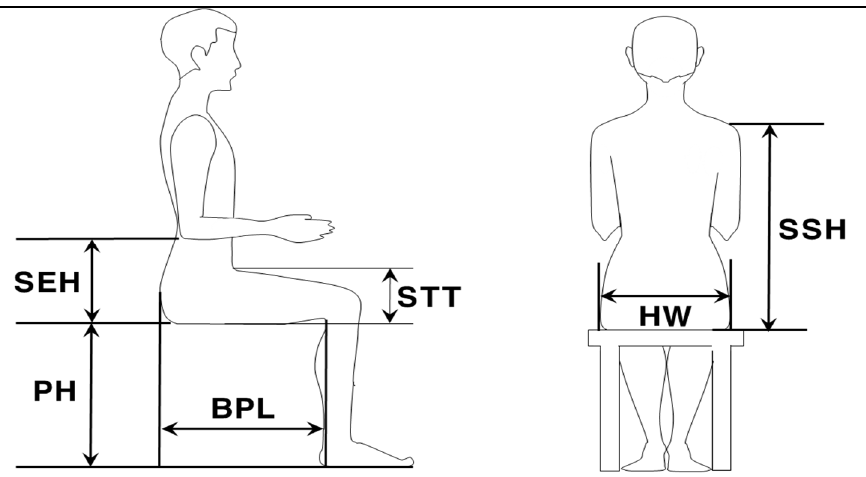
Figure 3. Anthropometric measures used in this study. Popliteal height (PH), vertical distance from the floor to the popliteal; hip width (HW), horizontal distance between the upper outer edges of the iliac crest bones of the pelvis; buttock to popliteal length (BPL), horizontal distance from the back of the buttocks to the popliteal; sitting thigh thickness (STT), vertical distance from the sitting surface to the superior thigh; sitting shoulder height (SSH), vertical distance from the sitting surface to the acromion; and sitting elbow height (SEH), vertical distance from the sitting surface to the underside of the elbow.